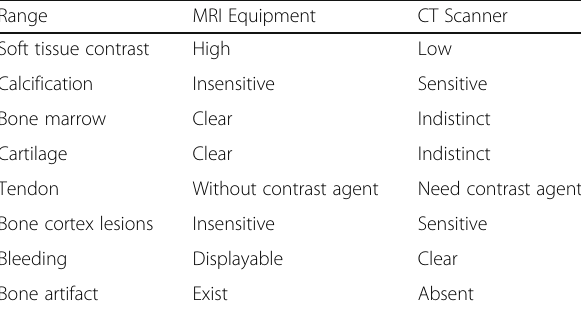
Table 1 The feature comparison of CT and MRI